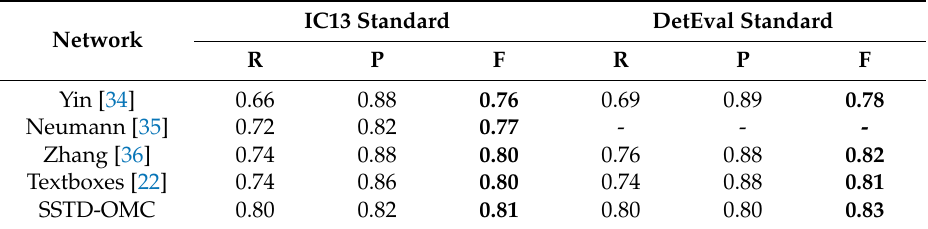
Table 4. Improved algorithm compared with other advanced algorithms (on